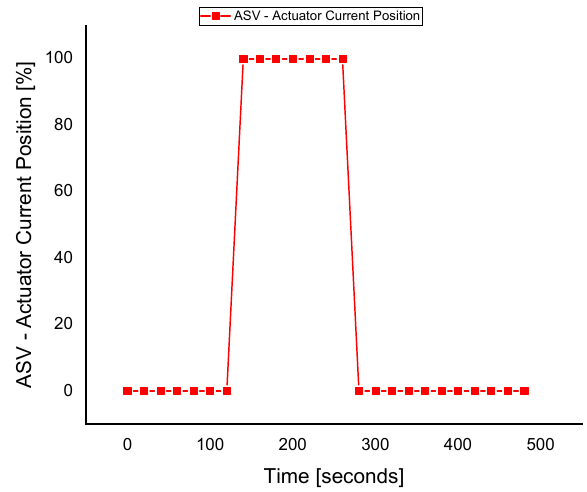
Figure 14. The actuator response during a fault in the P d sensor.